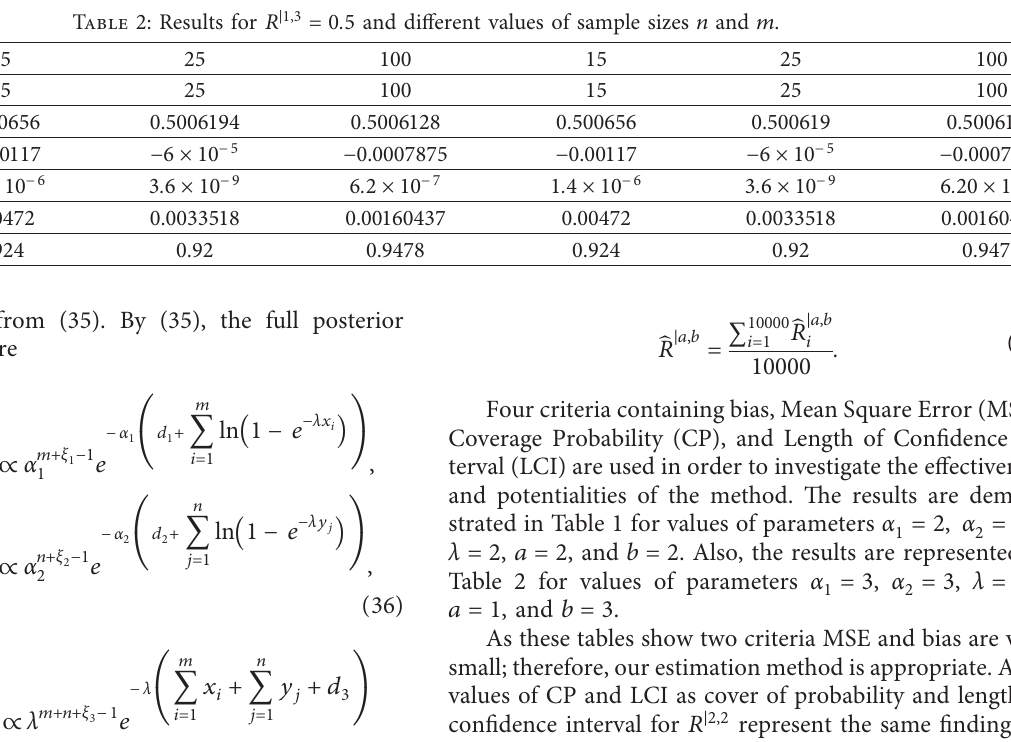
Table 2 for values of parameters α a � 1, and b � 3.